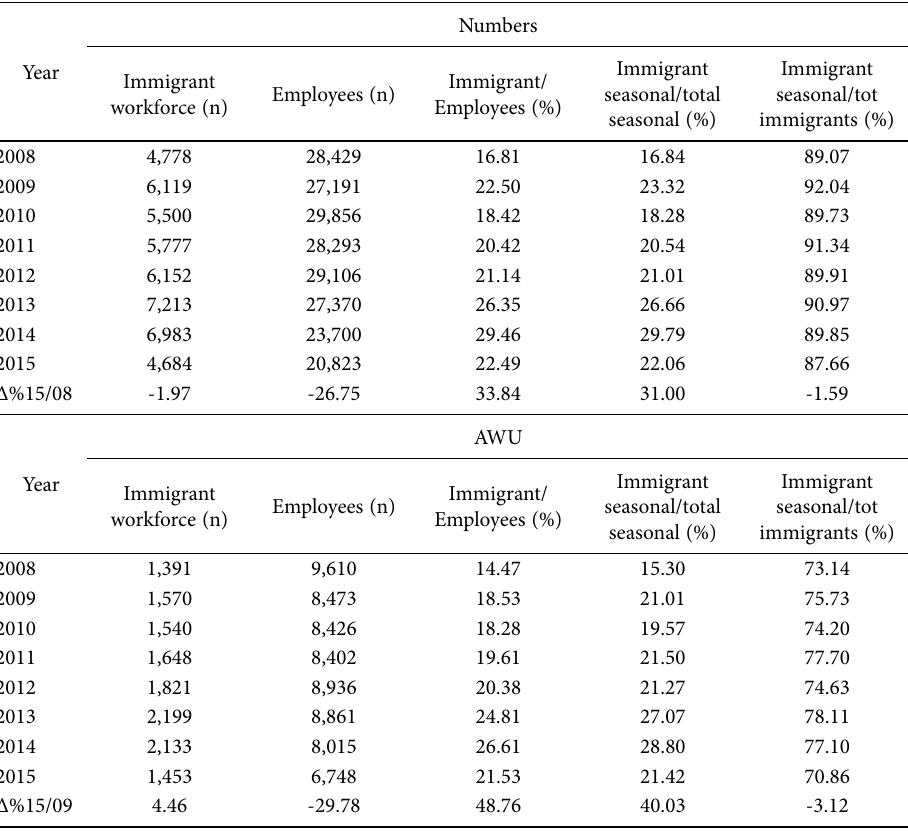
Table 2. Numbers and shares of immigrants and working units of immigrants by year. Italian FADN sample 2008-2015.